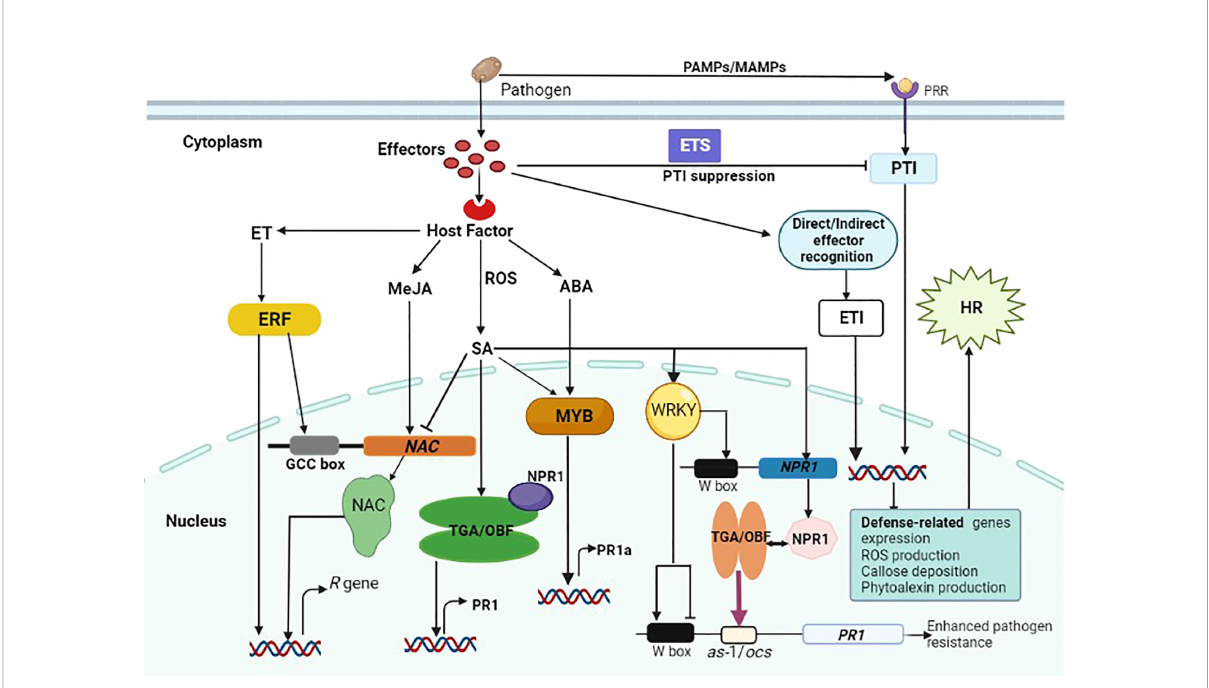
FIGURE 2 Schematic illustrations of a cross-talk between plant immune responses to fungal infection and the role transcription factors in gene expression regulation. Pathogen-derived conserved molecules (MAMPs) are recognized by pattern recognition receptors (PRRs), and this activates PTI. Pathogens induce susceptibility by interfering with the immune signaling network through effectors, resulting in effector-triggered susceptibility (ETS). Following direct or indirect effector recognition, plant R proteins activate host defense responses to stop pathogen growth, and this is regarded as effector-triggered immunity (ETI). Also, effector recognition triggers the induction of hormone signals and manipulated ERF, TGA, MYB and WRKY transcription factors to regulate the expression of R genes either directly or indirectly. Some transcription factors reciprocally regulate gene expression by binding to the corresponding promoter. There are many W-boxes within the NPR1 promoter that are necessary for gene expression. The NPR1 protein interacts with speci fi c TGA/OBF proteins, which are bZIP transcription factors, to regulate the expression of the PR1 gene. This increases their activity of DNA binding to the as -1/ ocs element in the PR1 promoter (indicated by purple arrow) resulting in enhanced resistance to pathogen infection. In the PR1 promoter, WRKY proteins seem to exert both transcriptional activation and repression, hence their regulatory functions are